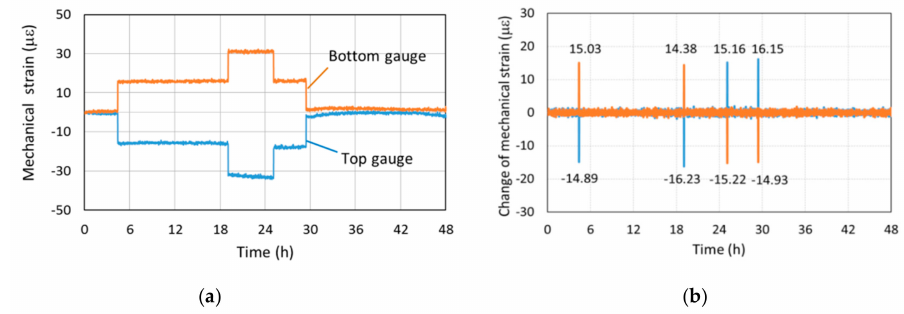
Figure 8. The steel beam test: ( a ) mechanical strain; ( b ) change in mechanical strain per unit